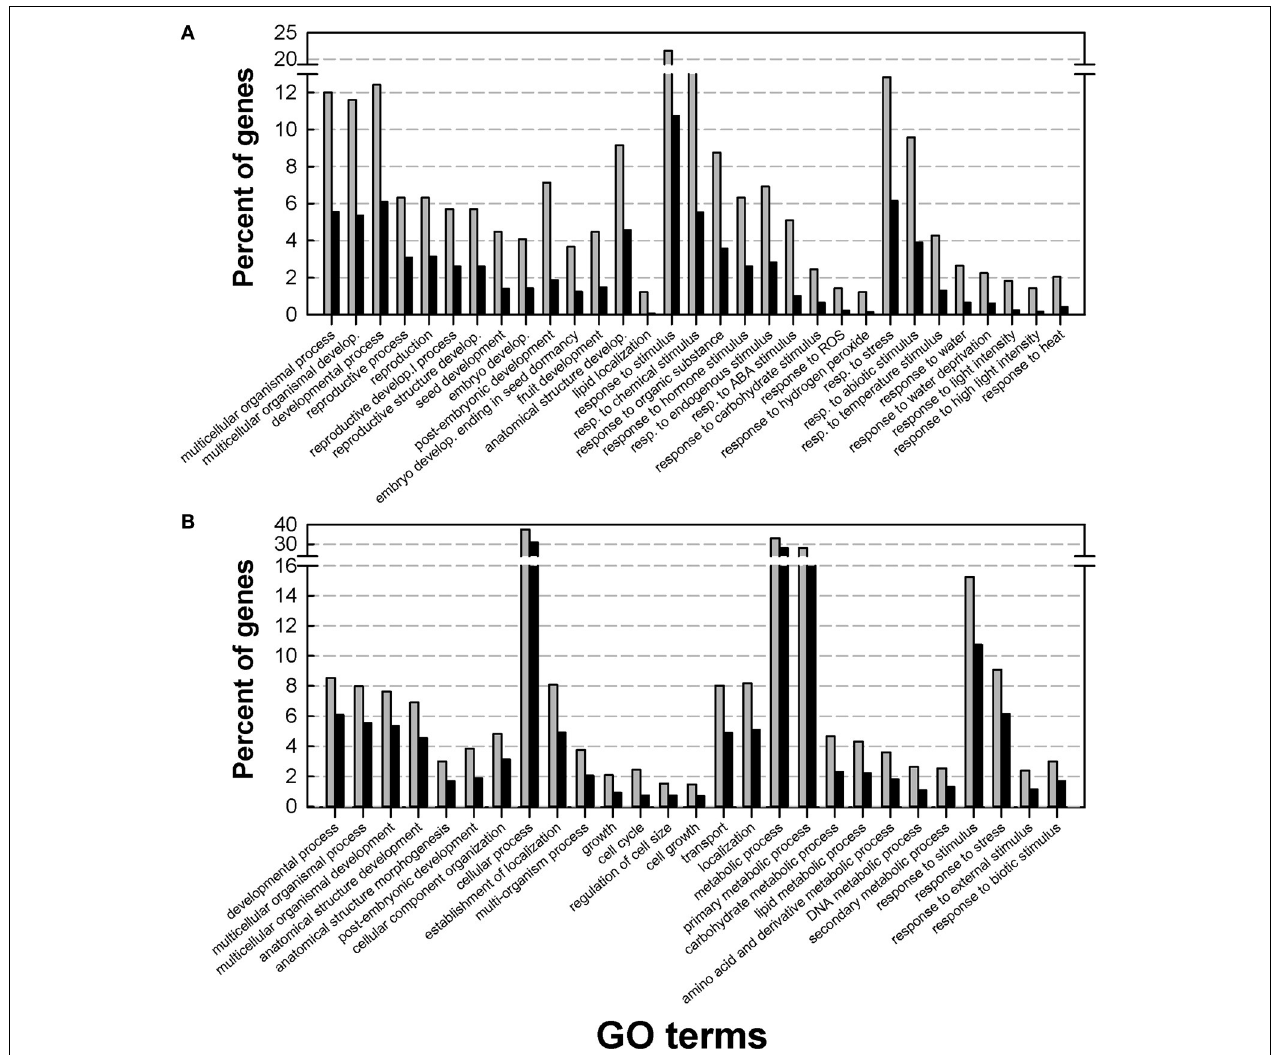
FIGURE 2 | Gene Ontology (GO) enrichment analysis of the desiccation tolerant UP list (A) and desiccation tolerant DOWN list (B). Analysis was performed on the DT-UP and DT-DOWN list from Figure 1 using AgriGO with